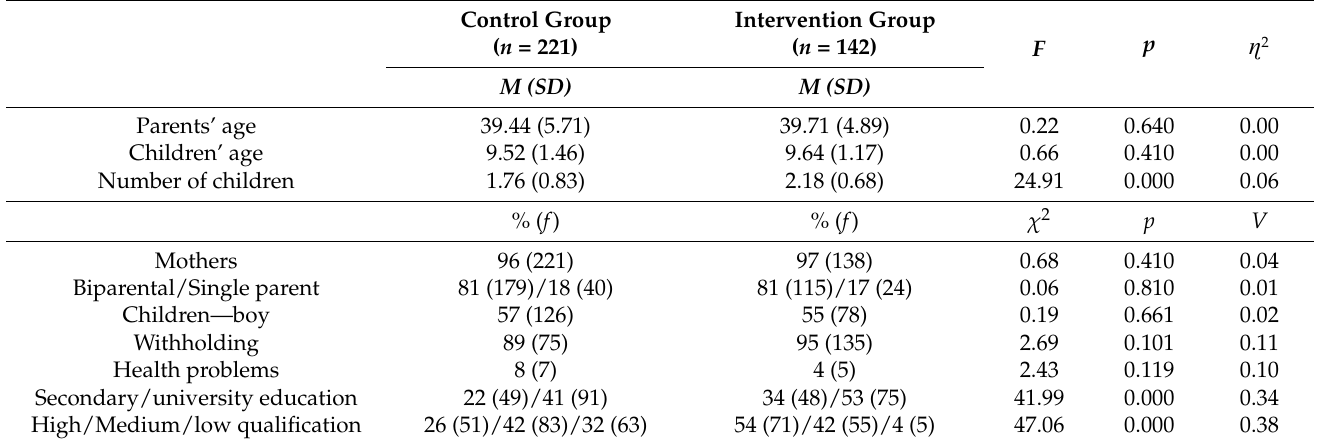
Table 1. Participants’ sociodemographic